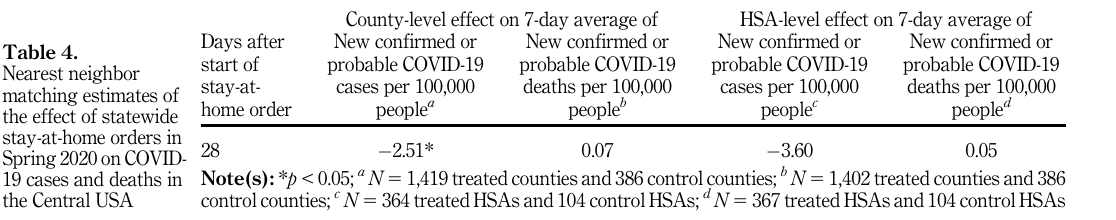
Table 4. Nearest neighbor matching estimates of the effect of